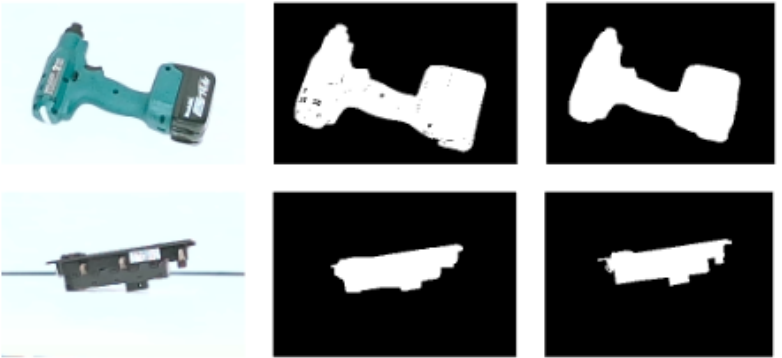
Figure 9. Closeups of examples of masks calculated by the standard EPOS masking method [45] ( middle column) and U-Net ( right column) along with the original image ( left column).